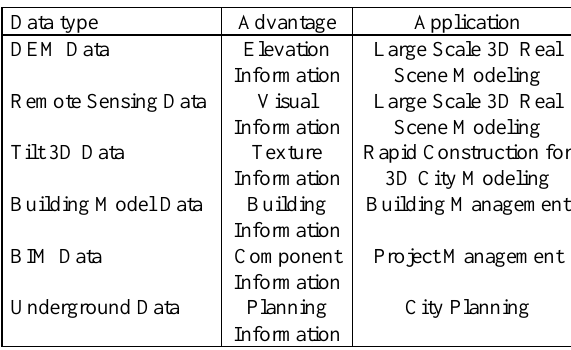
Table 1 . Comparison of Different Type of Data for 3D City